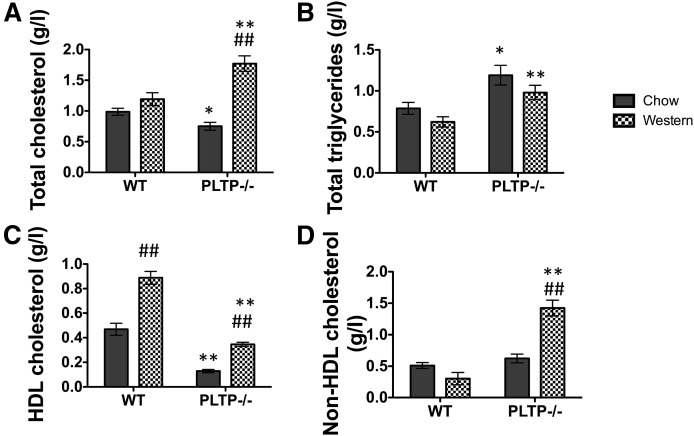
Western-type cholesterol-rich diet substantially increases plasma levels of cholesterol in PLTP−/− mice. Total cholesterol (A), triglycerides (B), and HDL-cholesterol (C)were assayed in plasma samples from WT (n = 8) and PLTP−/− (n = 8) mice after they had been fed for 4 weeks either with a standard chow diet or a Western-type diet. Non-HDL cholesterol was calculated as the difference between total and HDL-cholesterol (D). Results are expressed in grams per liter and correspond to mean ± SEM (*P < 0.05,**P < 0.001 vs. WT, Student’s t-test; #P < 0.05, ##
P < 0.001 vs. chow, two-way ANOVA analysis with Bonferroni’s post hoc analysis).